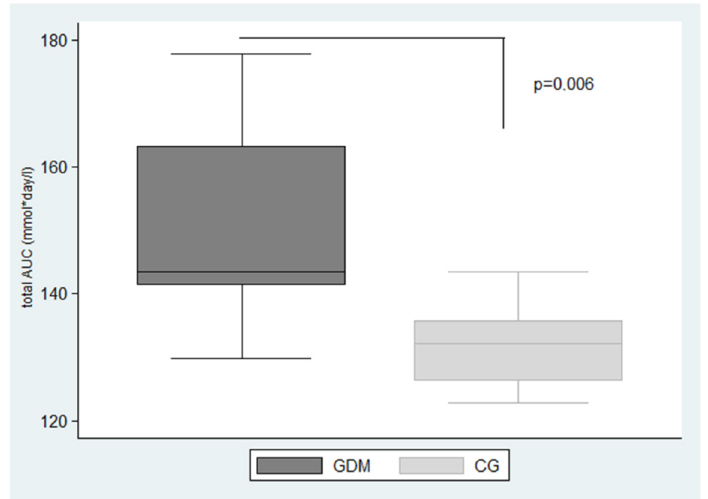
Figure 2. Box plot graph: the significant difference in glycaemic variability in GDM and CG compared by Total AUC (range 7.8–3.5 mmol/L). Data expressed as median (interquartile range): GDM, gestational diabetes mellitus; CG, control group; Total AUC, the area under the interstitial glucose concentration curve for the entire day. The significance is set at p <